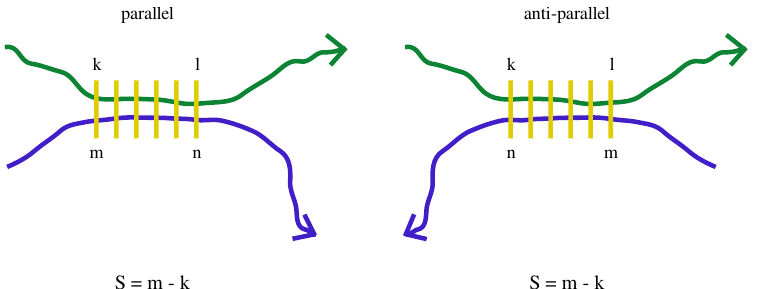
Figure 1. Schematic diagram showing β -pairings between two amino acid chains for parallel and anti-parallel orientations. The pairing amino acids are connected by yellow lines. The register shifts in both cases are indicated below the diagrams. In this work the two chains share the same